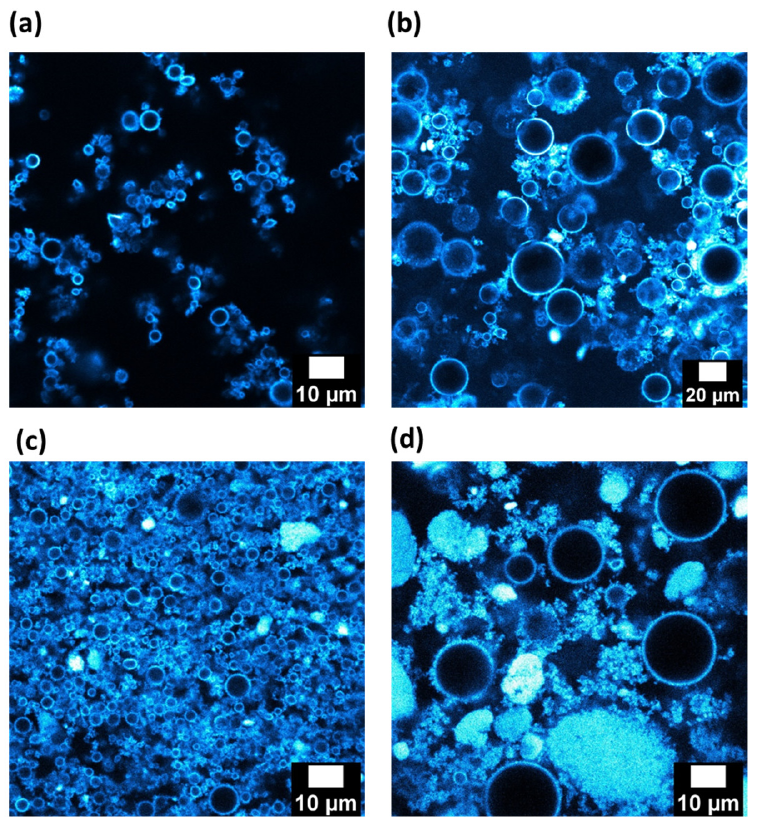
Figure 9. Confocal fluorescence images of ( a , c ) Water/Paraffin and ( b , d ) Water/Dodecane reverse emulsions prepared with ( a , b ) 1 wt.% and ( c , d ) 4 wt.% of partially hydrophobic silica particles.